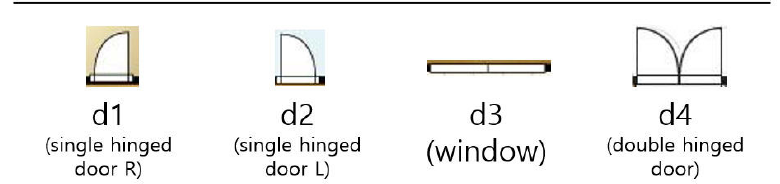
Figure 5. Opening